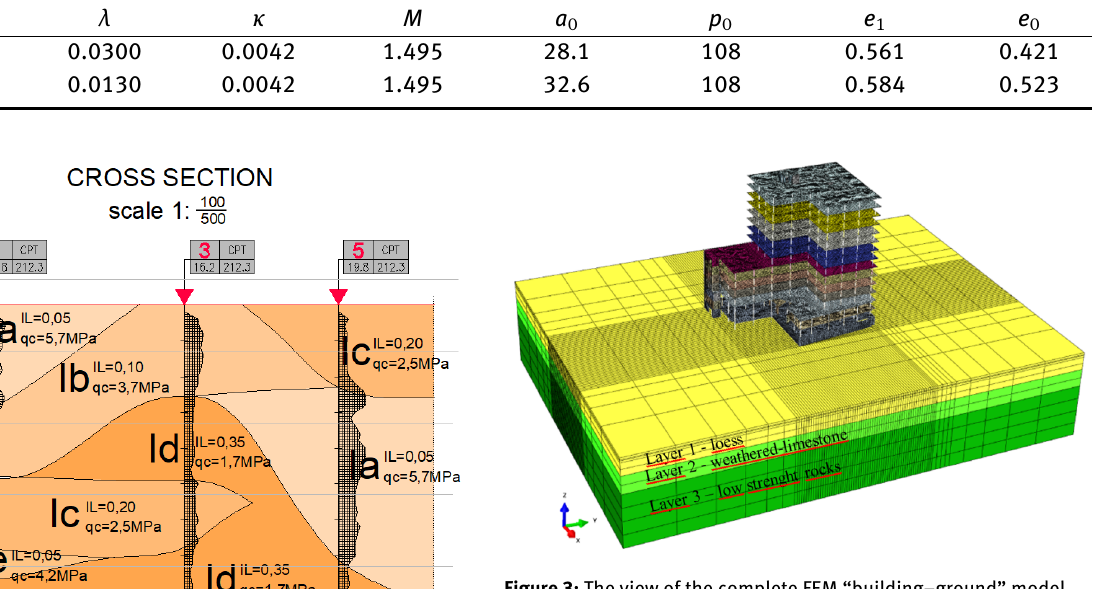
Figure 3: The view of the complete FEM “building–ground” model